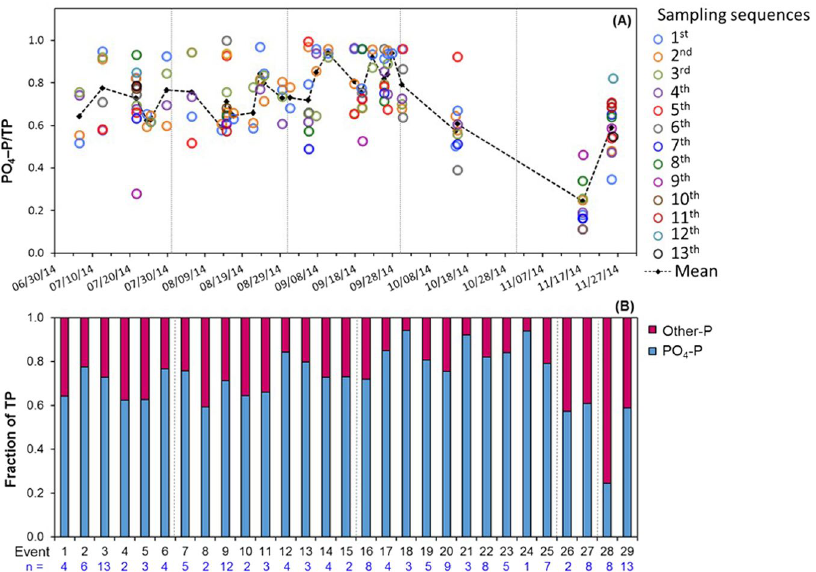
Figure 2. ( A ) Proportion of PO 4 –P to TP in stormwater runoff (n = 153) with sampling sequences 1 to 13, which refer to individual samples collected in 5-minute intervals during each event. The dashed line shows change of mean values from individual events. ( B ) Fraction of PO 4 –P and other–P in residential stormwater runoff over 29 sampling events (n = 153). Event 1–6, 7–15, 16–25, 26–27, and 28–29 occurred in July, August, September, October, and November, respectively. Numbers in blue are total number of sequential 5-minute samples collected during each